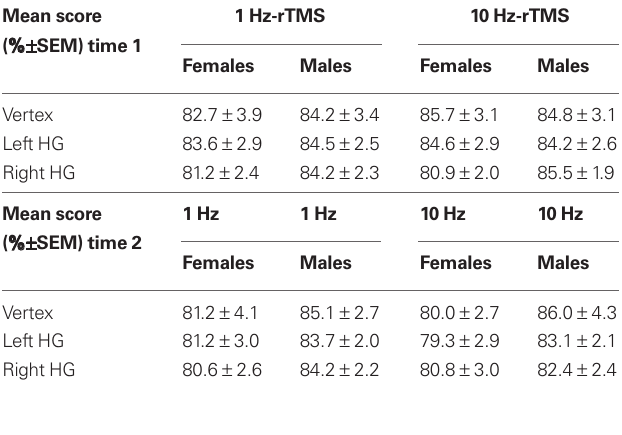
Table 4 | Mean score (% ± SeM) for each condition (i.e., sex, rTMS frequency, and area stimulated) at time 1 (0–5.5 min) and time 2